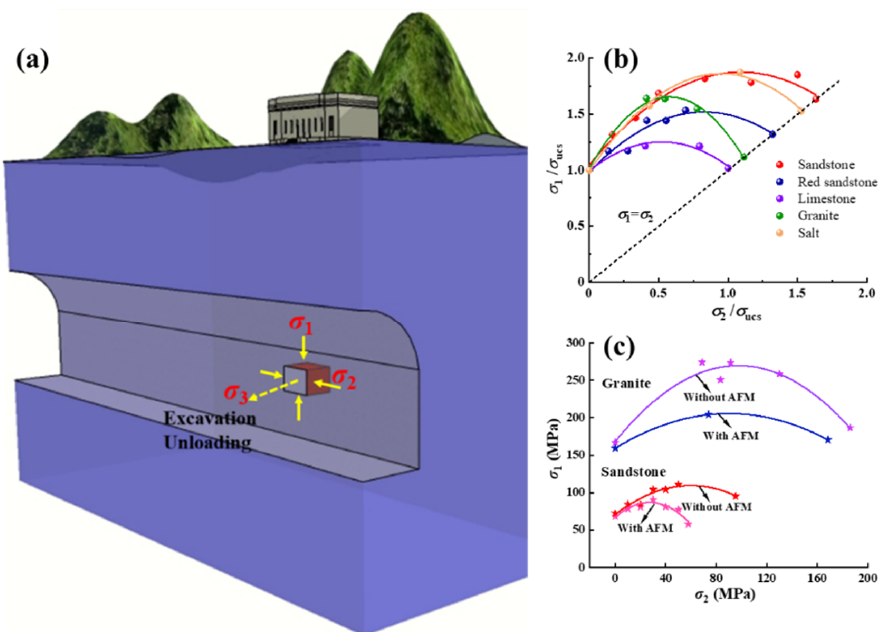
Figure 1. Stress state and the associated strength characteristics, including ( a ) biaxial stress state in rock around underground opening, ( b ) σ bcs envelope curves, and ( c ) difference between rock strengths with anti-friction measures (AFM) and these without AFM.